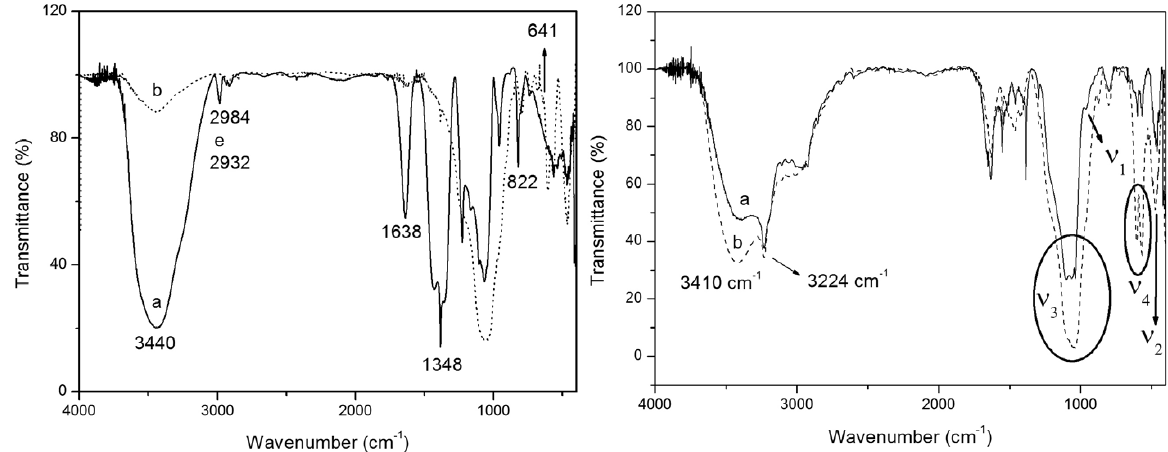
Figure 6 - FTIR of the samples HAS dried at 50°C and treated at (a) 110°C and (b) 900°C (A) , and after contact with SBF for three days, (a) 110°C and (b) 900°C (B)